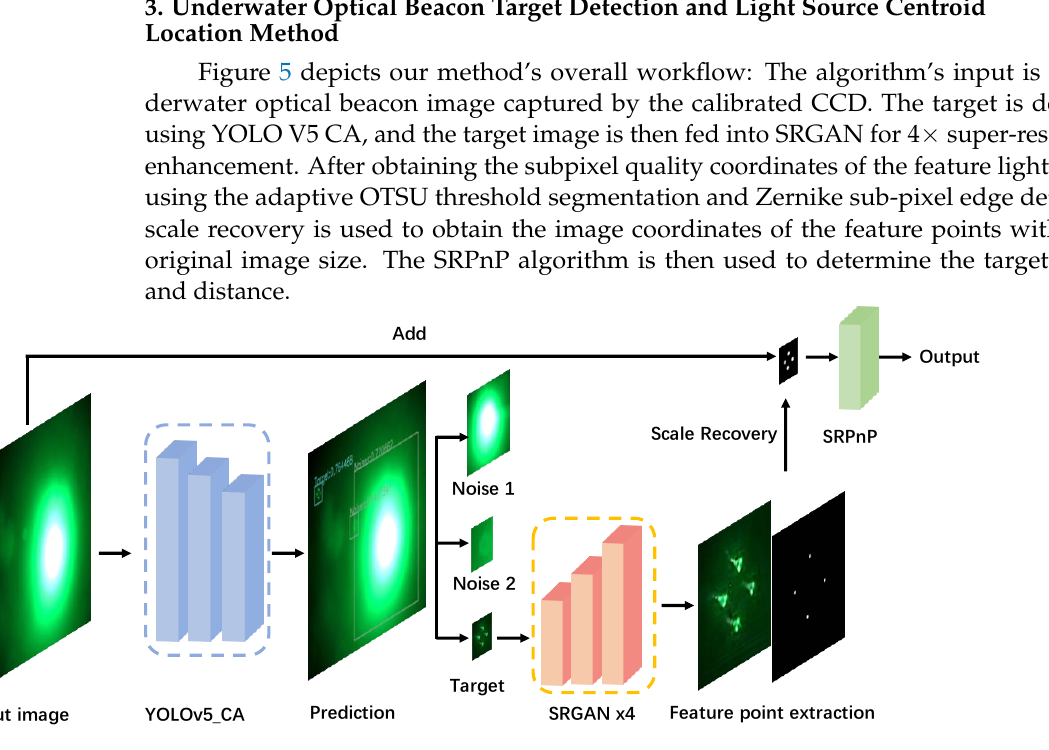
Figure 5. Flow chart of visual positioning algorithm.